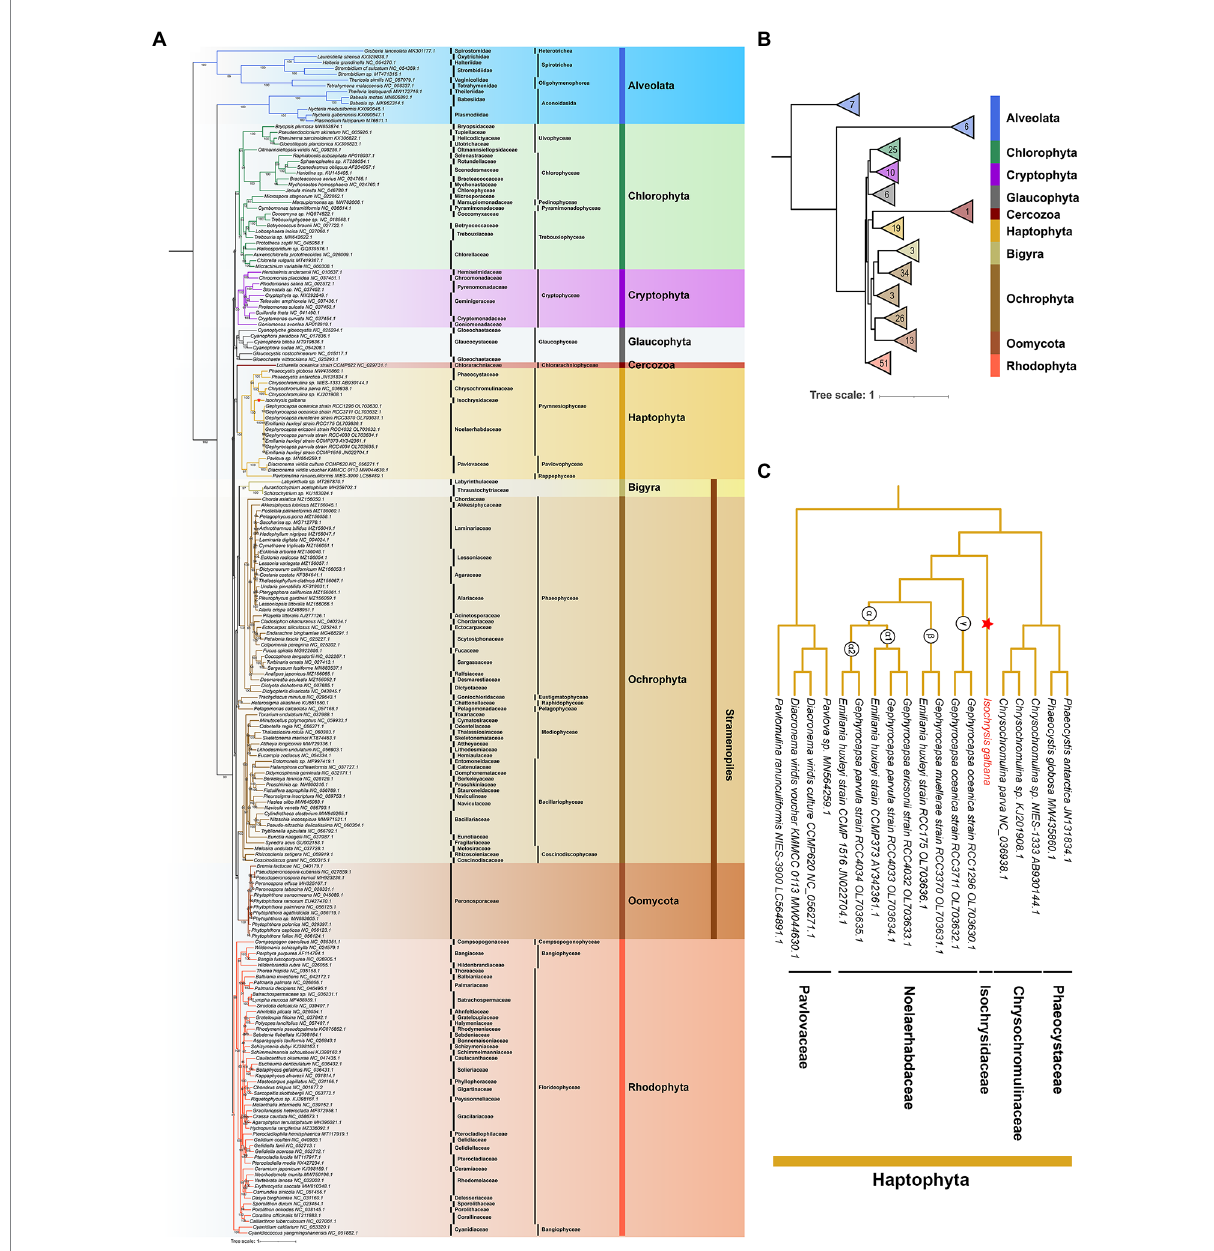
FIGURE 5 Maximum-likelihood (ML) phylogenetic analysis of COX1 proteins. (A) The ML phylogenetic tree constructed by COX1 coding sequences of 204 mitogenomes. The ML phylogenetic tree was constructed with coding sequences of the single-copy gene cox1 from 204 selected mitogenomes of eight lineages (10 algae phyla) consisting of five red-algal lineages (Cryptophyta, Alveolata, Stramenopiles, Haptophyta and Rhodophyta), two green-algal lineages (Chlorophyta and Cercozoa) and Glaucophyta. Taxa are colored according to the corresponding phylum. Maximum- likelihood bootstrap support are indicated at nodes. NCBI GenBank accession numbers were listed next to their corresponding species. Scale bar represents amino acid substitutions per site. (B) Main phylogenetic topology of 10 algae phyla inferred by COX1 proteins. (C) Phylogenetic relationships of 18 haptophyte mitogenomes based on COX1